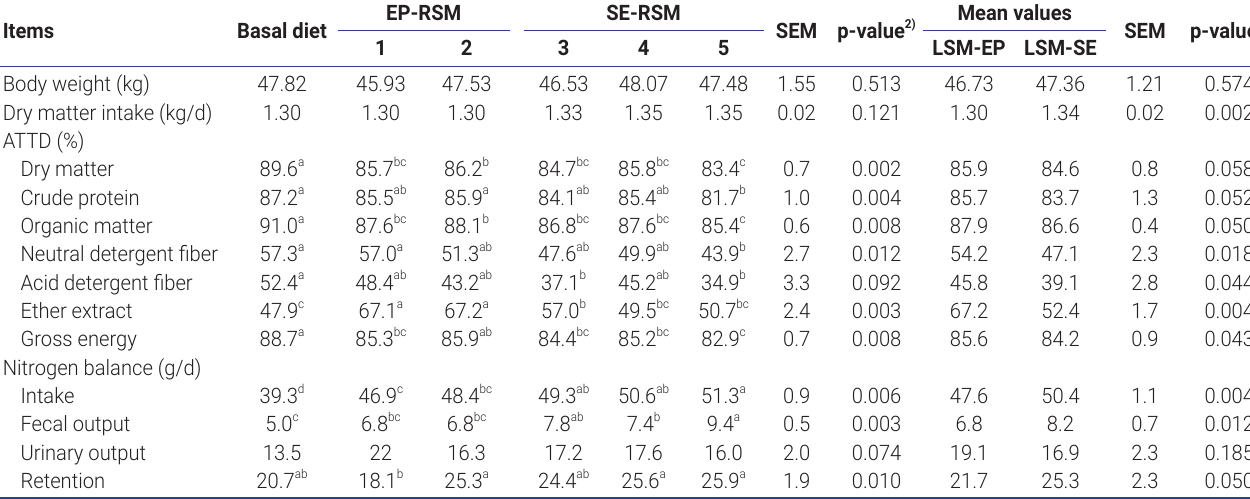
Table 3. Effect of diet characteristics on energy and nitrogen balances of growing pigs 1)